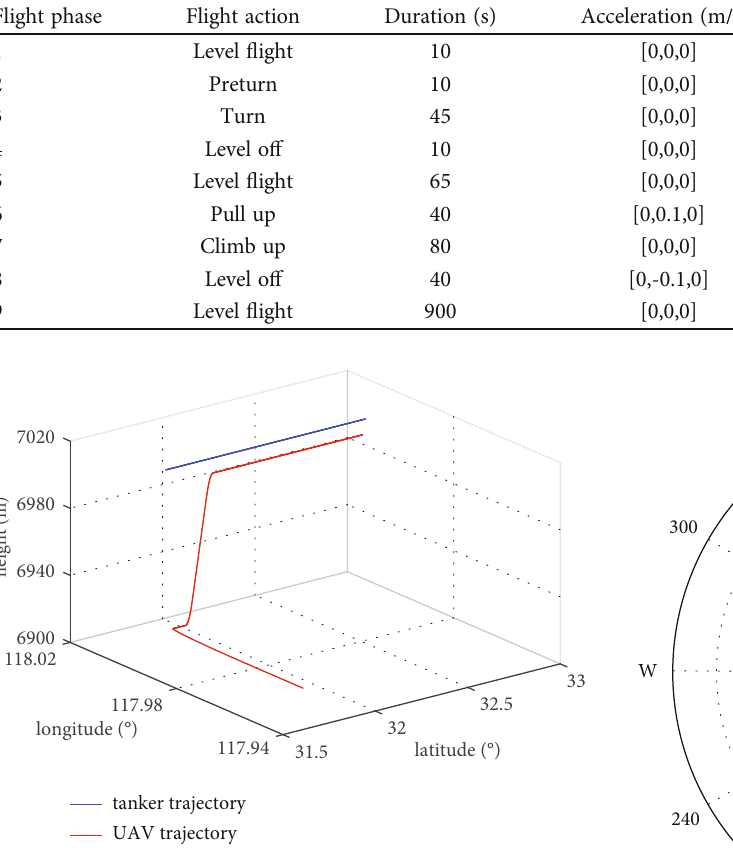
Figure 3: The trajectories of the tanker and the UAV.